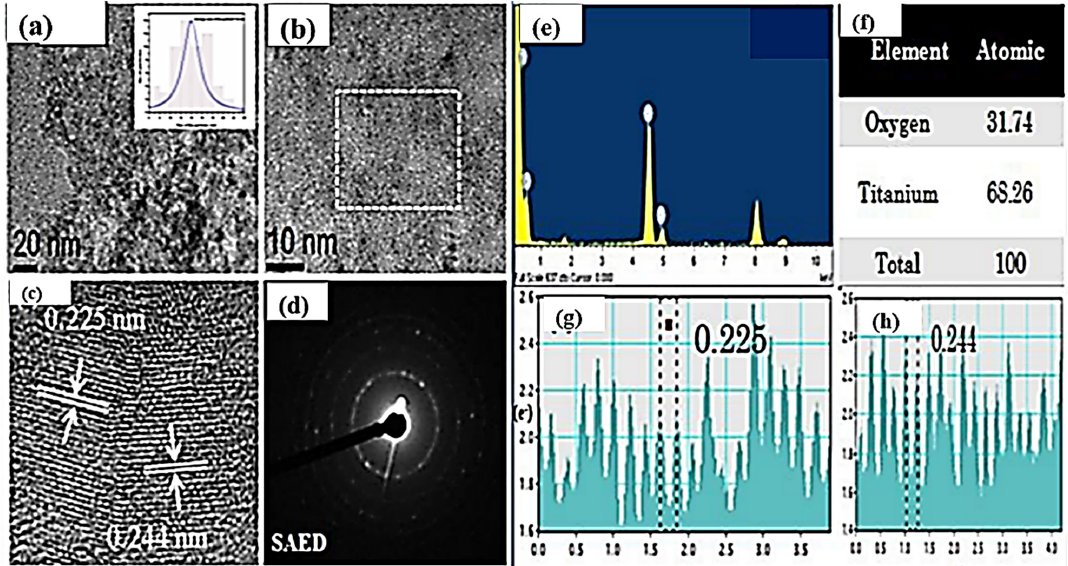
Figure 3. HRTEM images of synthesized TiO 2 NPs, ( a ) TEM micrographs with histogram, ( b ) HRTEM images, ( c ) lattice parameter and ( d ) SAED pattern of TiO 2 . ( e ) EDX spectra ( f ) atomic % of Ti and O, ( g , h ) particle d-spacing analysis. Figure 4a–f show HRTEM and EDX images of the AC-TiO 2 . Micrographs of the analysed samples show powdered carbon substances surrounding the open face of TiO 2 .